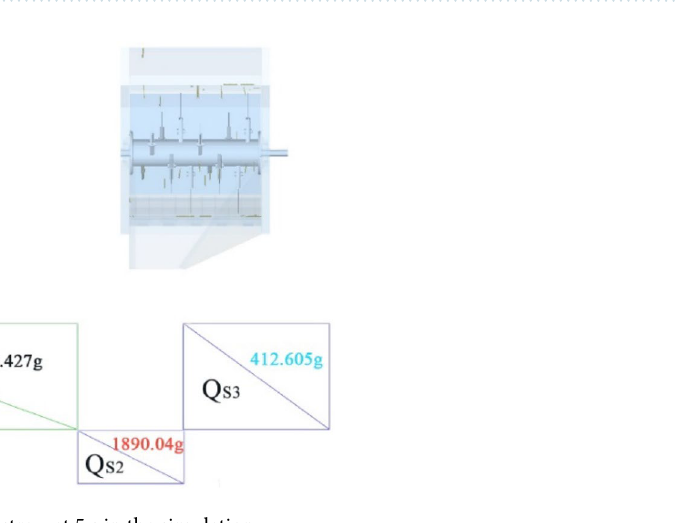
Figure 10. Scattering state of straw at 2 s in the simulation. ( A ) X direction view, ( B ) Y direction view, ( C ) Z direction view.